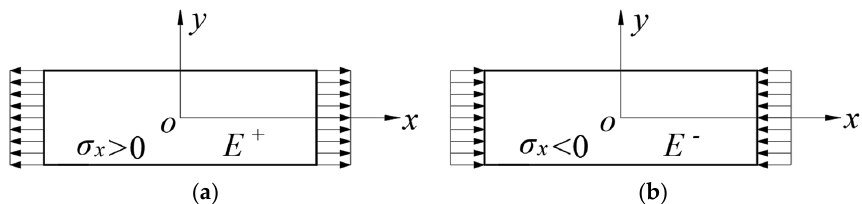
Figure 3. Uniaxial tension or compression and corresponding modulus: ( a ) uniaxial tension; ( b ) uniaxial compression, in which σ x is the stress.